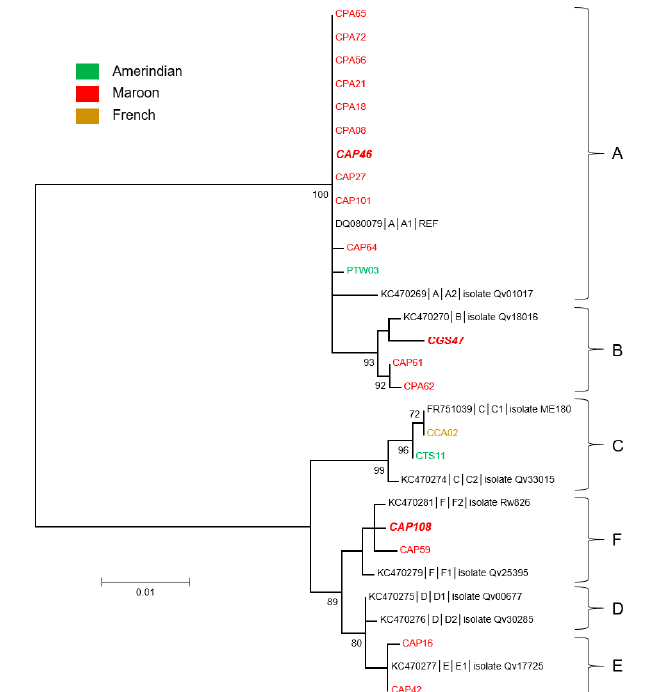
Figure 6. Phylogenetic tree of HPV68 variants from French Guiana. Maximum likelihood phylogenetic tree of HPV68 variants based on 804 bp of E6 and E7 concatenated sequences. Six clusters were identified as lineages A, B, C, D, E and F. Only bootstrap values above 70% are represented in the branches. The tree is drawn to scale with branch lengths measured in the number of substitutions per site. Newly generated sequences, here identified by their IDs, are color-coded according to the mother-tongue of the women from whom they were obtained. Oversized sequences in bold and in italics are those obtained from women with an abnormal cytology (either ASCUS, ASC-H, LSIL, HSIL, or glandular anomalies).